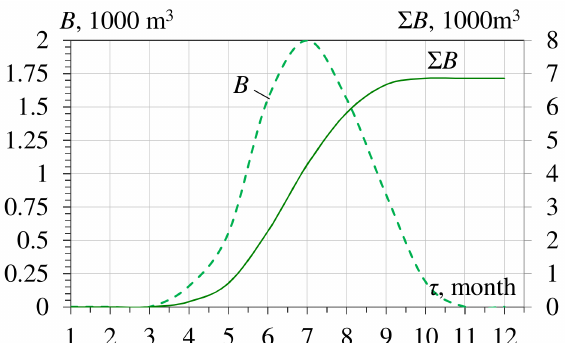
Figure 11. Monthly B and annual fuel saving Σ B for gas engine JMS 420 GS due to inlet air cooling in AECh (Mykolayiv region, south of Ukraine,